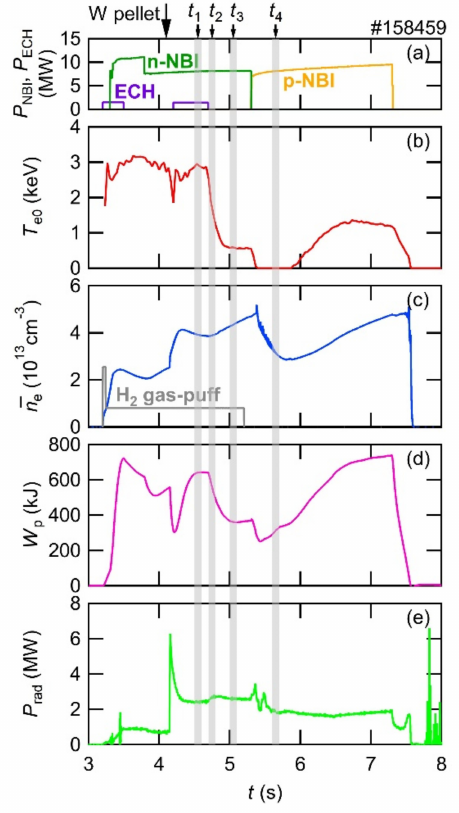
Figure 2. Typical waveform of W pellet injection experiment in LHD: ( a ) heating power of ECH, n-NBI, and p-NBI, ( b ) central electron temperature, ( c ) line-averaged electron density, ( d ) plasma stored energy, and ( e ) total radiation power. Four timings of data acquisition, t 1 = 4.5 s, t 2 = 4.7 s, t 3 = 5.0 s, and t 4 = 5.6 s are indicated